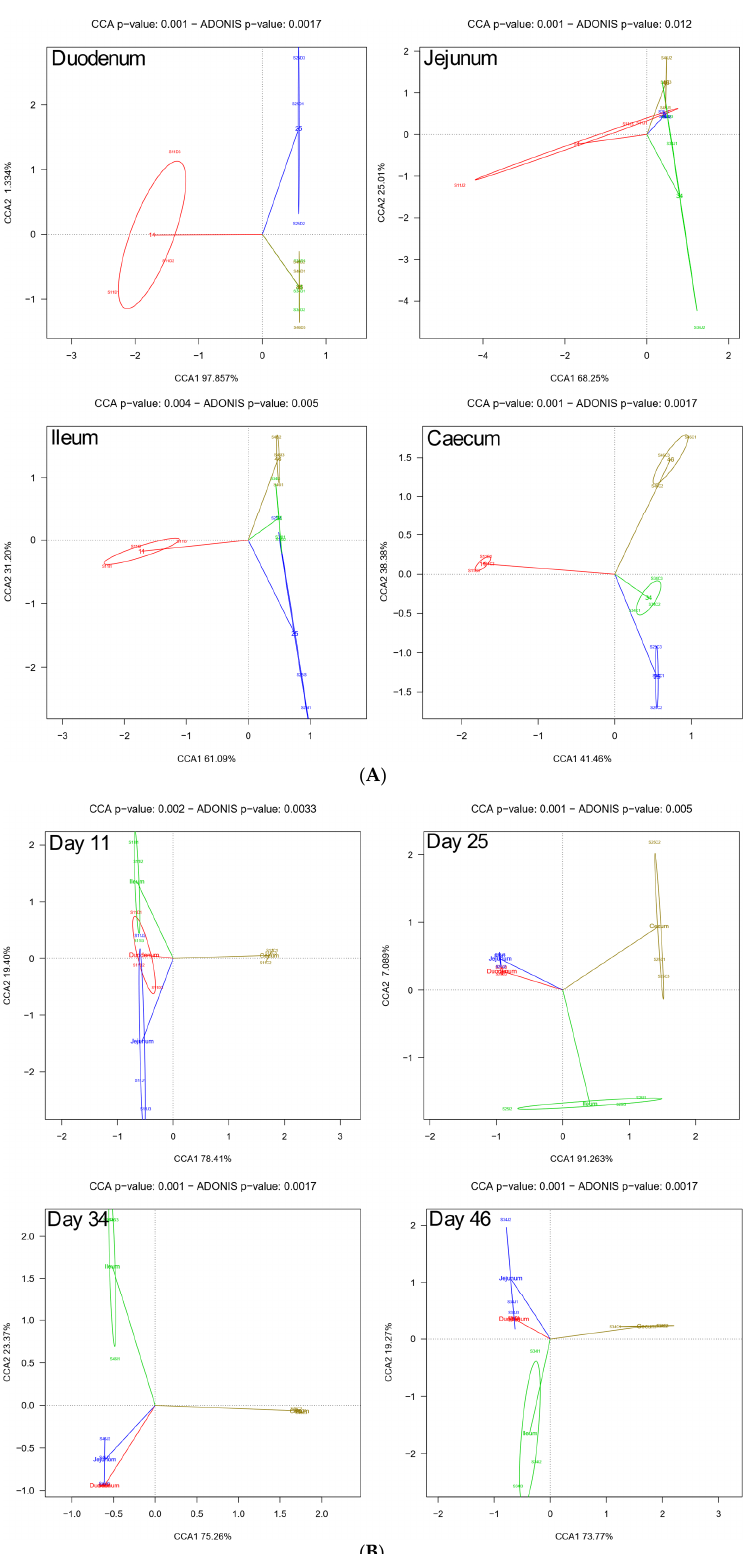
Figure 5. Taxonomic beta diversity. Canonical correspondence analysis (CCA) plots and Adonis test for significance of gut microbiota at the genus level for each intestine segment (panel A ) and each age (panel B ). Each color represents the age (11, red; 25, blue; 34, green and 46, brown) in panel A and the intestine segment (duodenum, red; jejunum, blue; ileum, green and caecum, brown) in panel B .